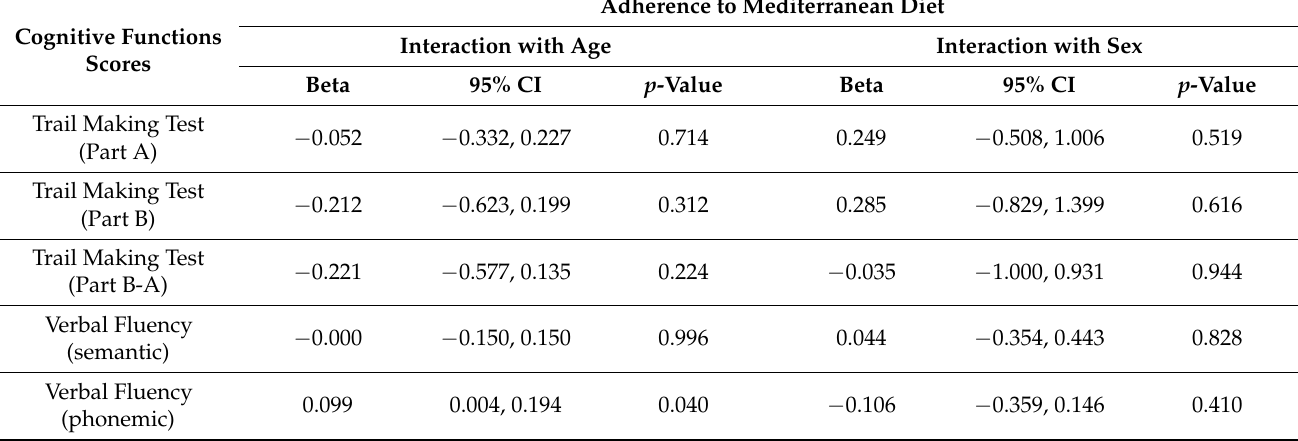
Table 3. Results of multiple linear regressions for the association between adherence to the Mediterranean diet and cognitive function (continuous score) with the interaction terms by age and sex among Epirus Health Study